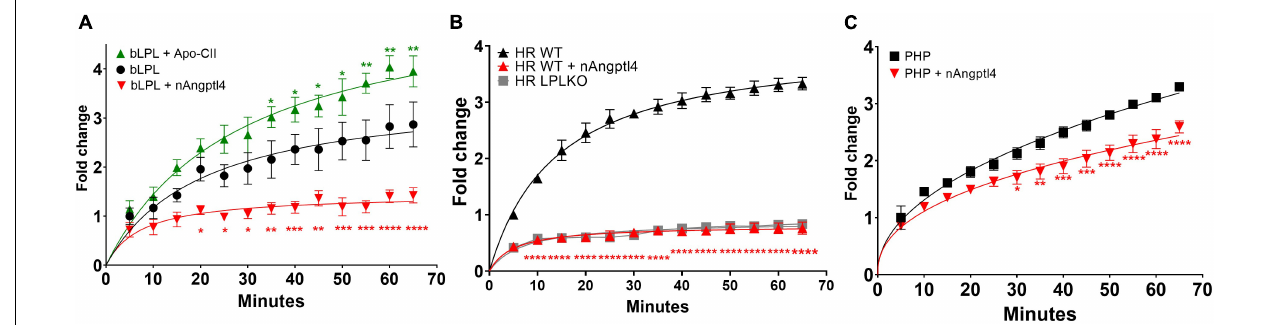
FIGURE 5 | Fluorescence detection of LPL activity using the EnzChekTM substrate, ApoC-II activation and nAngptl4 inhibition to determine LPL activity using (A) bLPL (B) heparin-released (HR) LPL from LPL secreting BV-2 microglia, and LPL knock out (LPL KO) cells as a control, and (C) PHP as a source of LPL. * P < 0.05; ** P < 0.01; *** P < 0.001; **** P <